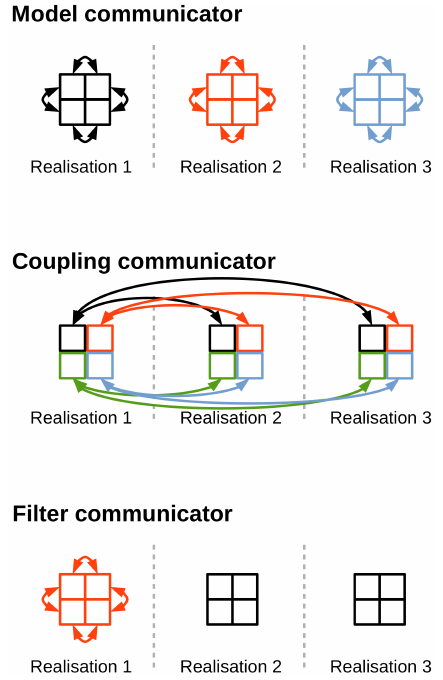
Figure 2. Communicators in PDAF for a parallel set-up with three ensemble members and four processors per ensemble member. Colours indicate the membership of the respective processors and arrows exemplify the parallel communication between the different